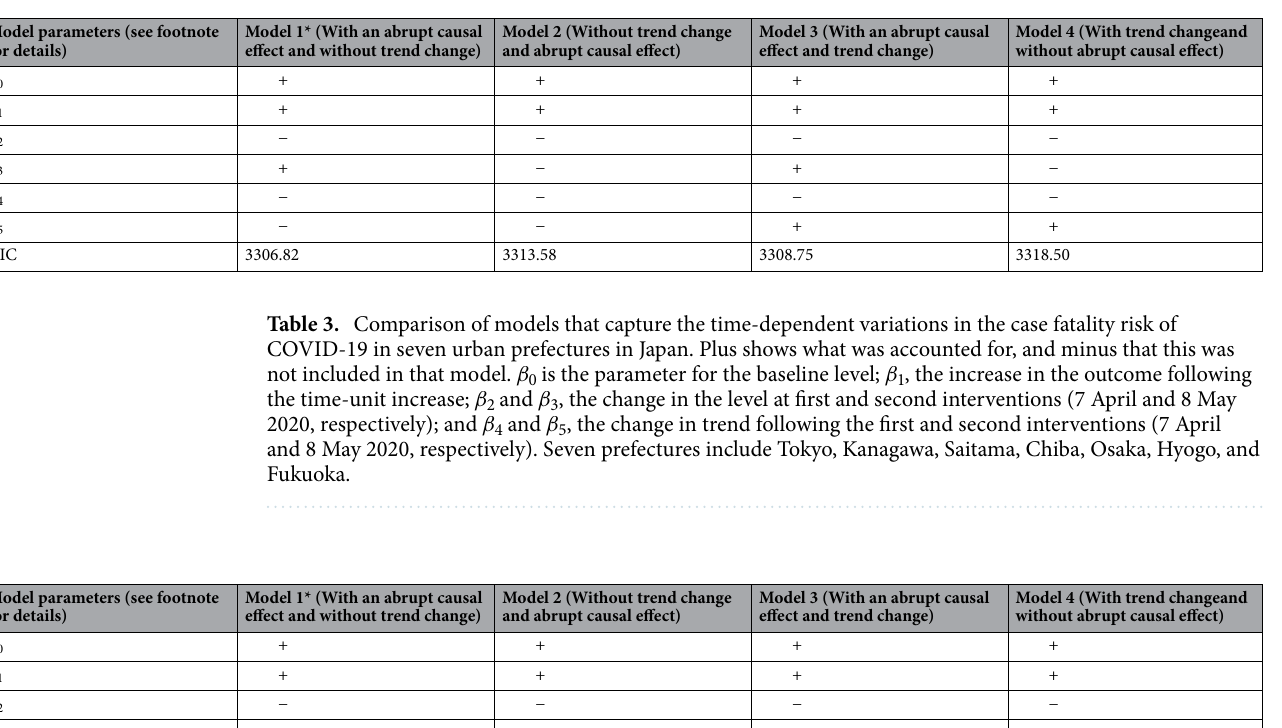
Model parameters (see footnote for